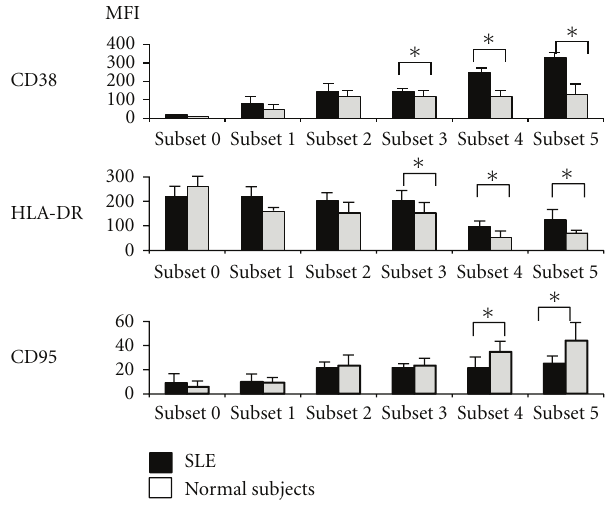
Figure 4: Comparison of surface expression of various antigens with significant di ff erence of mean of MFI on RP105( − ) B cell subsets between SLE patients and normal